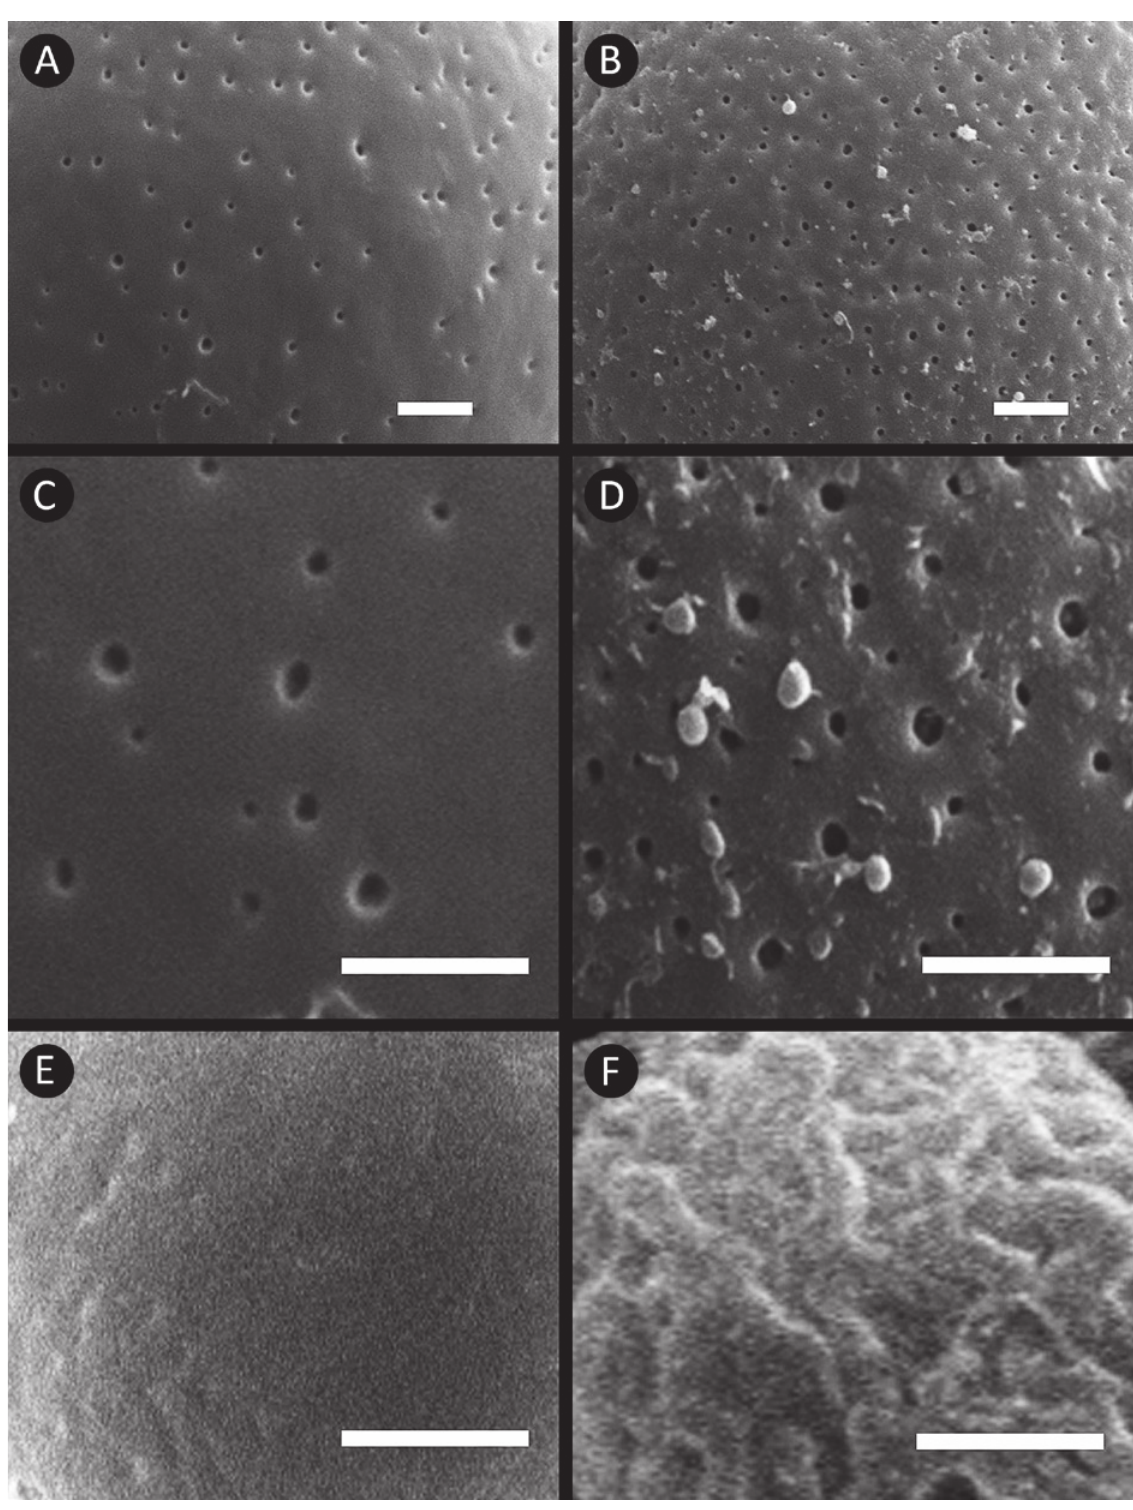
Fig 3 - Exine types in the genus Lippia . (A-B) perforate type, (C) perforate with few puncts per area, (D) perforate with many puncts per area, (E) psilate, (F) scabrate. Bars =